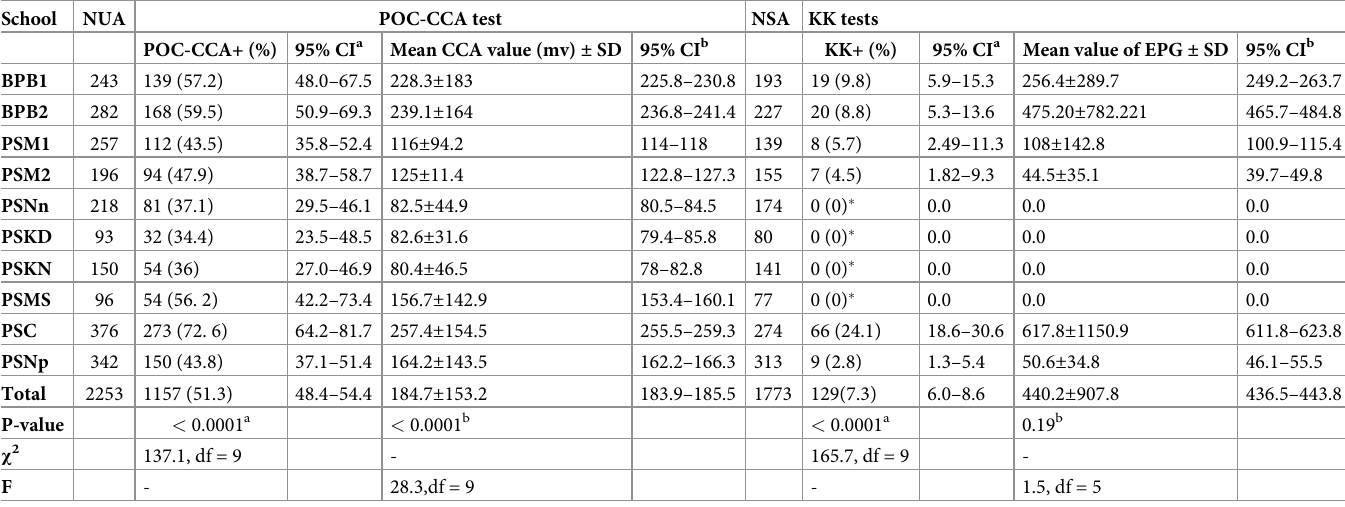
Table 2. Prevalence and infection intensity of S . mansoni infections according to